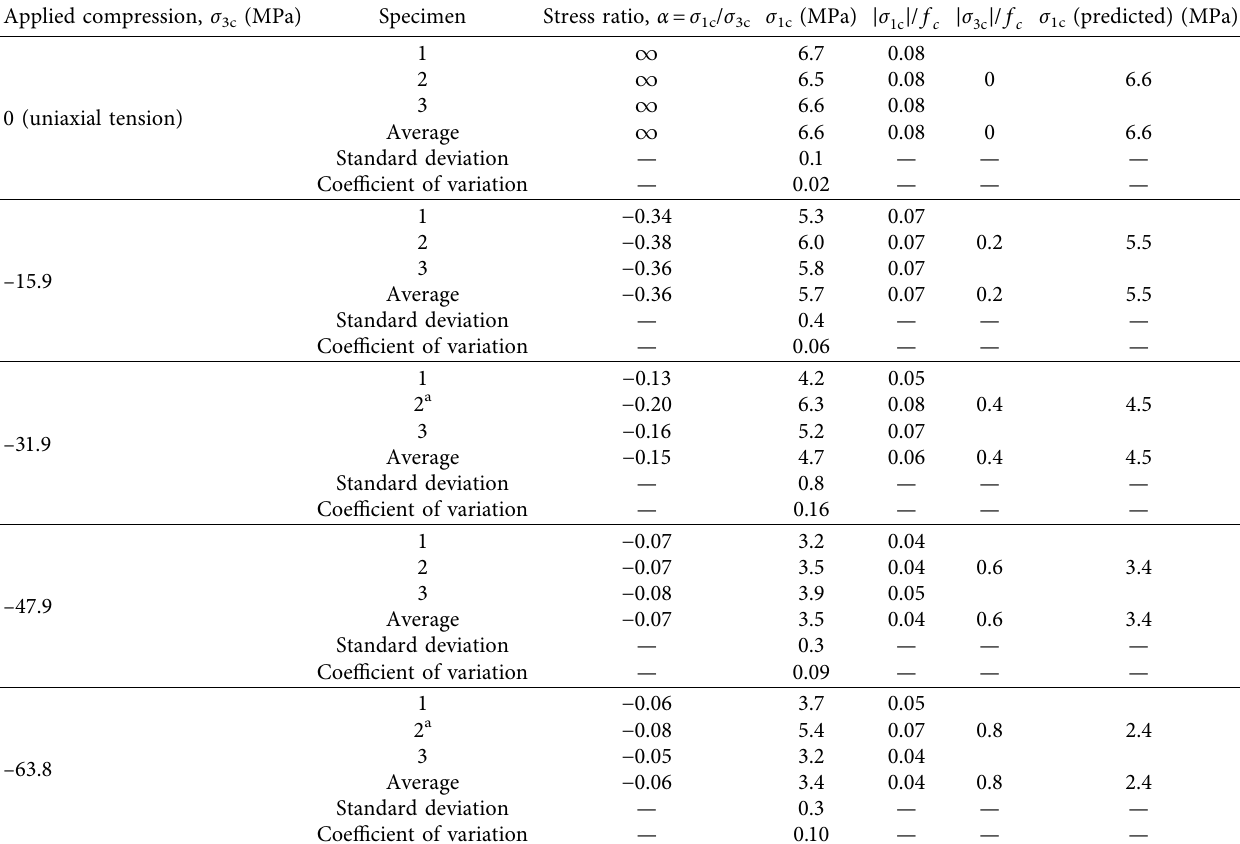
Table 4: Strength of RPC specimens under